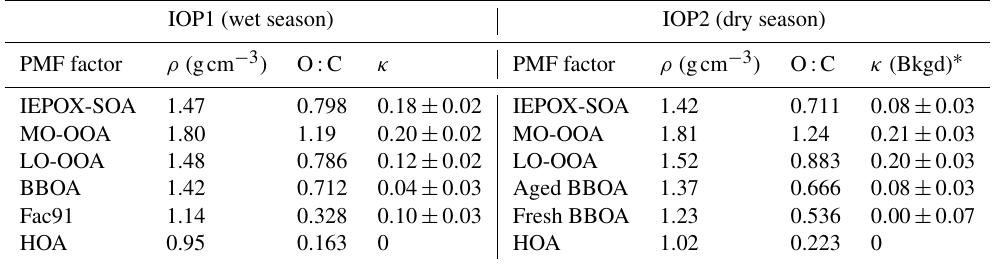
Table 1. Density, O:C ratio, and hygroscopicity associated with organic factors derived from positive matrix factorization (PMF) analysis. For IOP1 and IOP2, hygroscopicities of PMF organic factors were derived from time series of particle hygroscopicity under all conditions and background conditions,